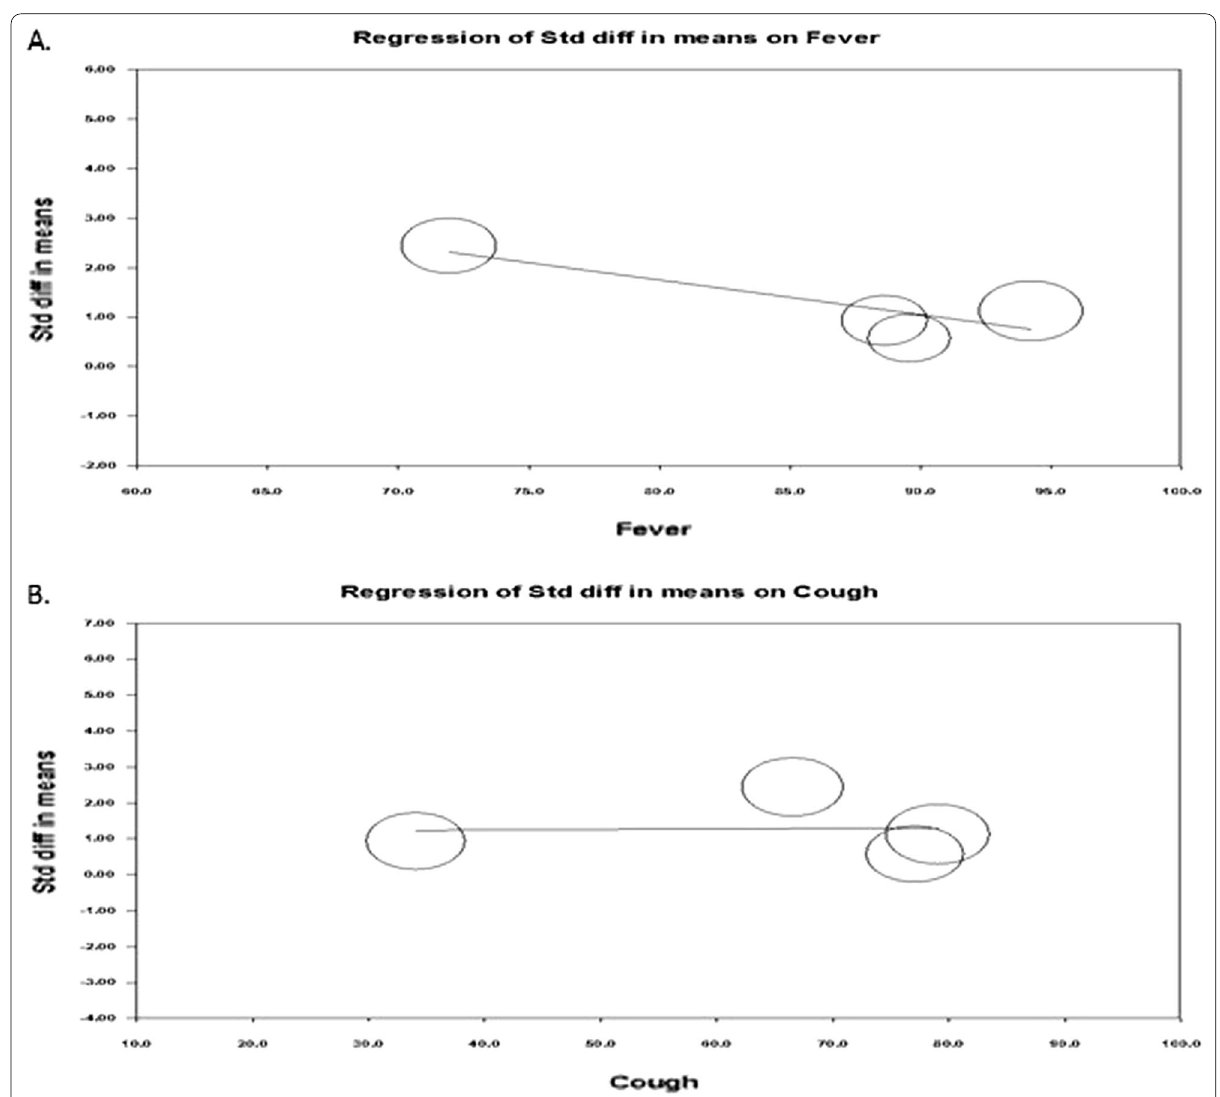
Fig. 7 Regressin analysis of effect size on covariates fever rate ( A ) and cough rate ( B